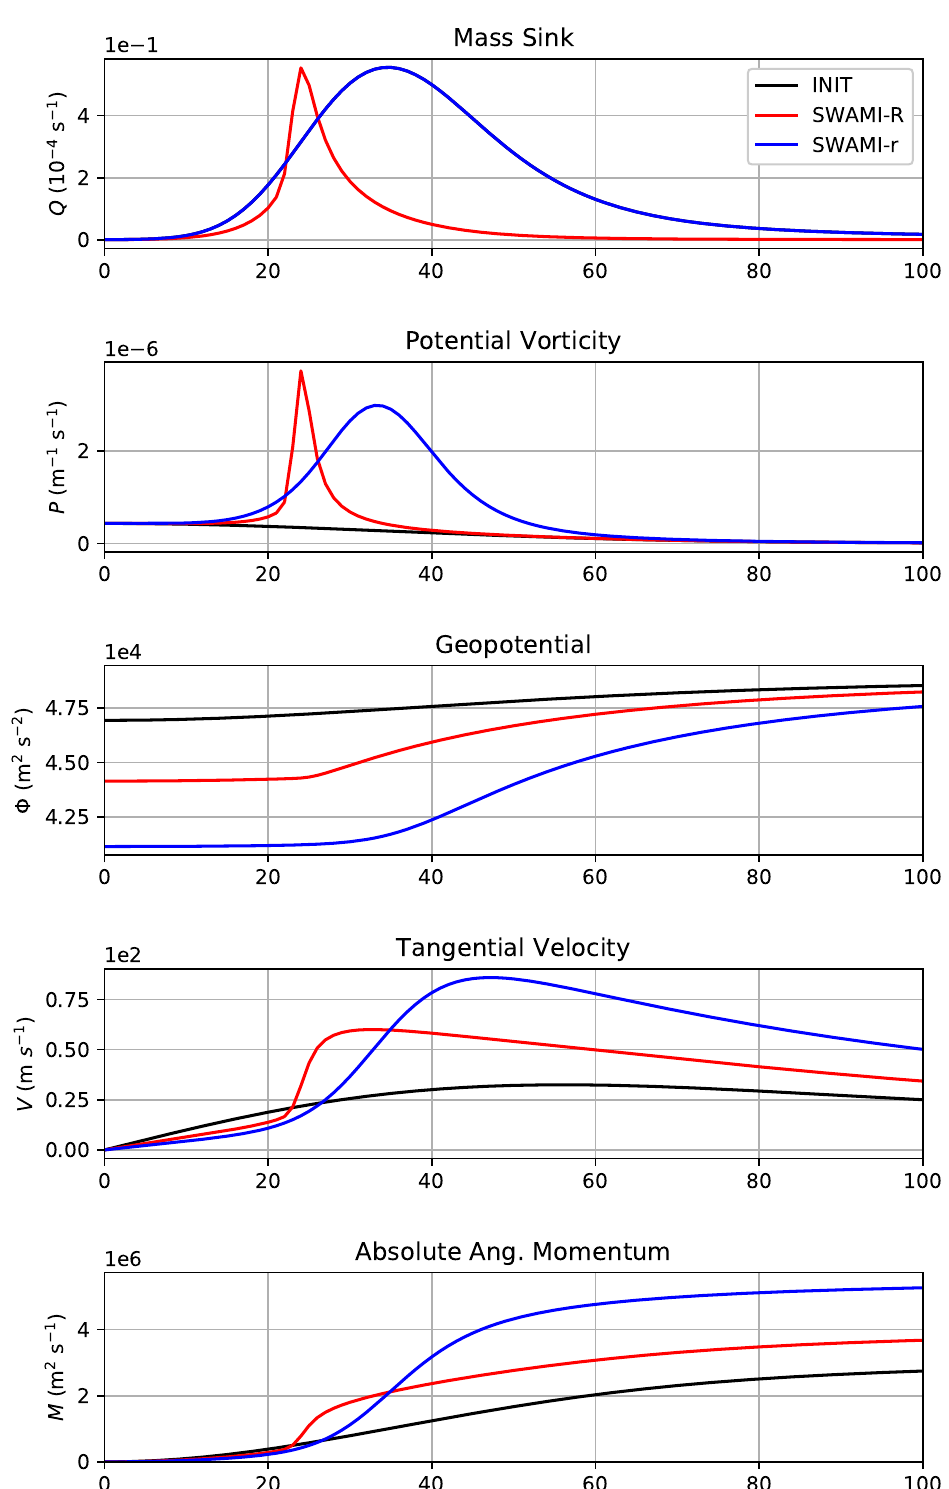
Figure 3. Same as Figure 1 but with ˙ θ = 6 K h − 1